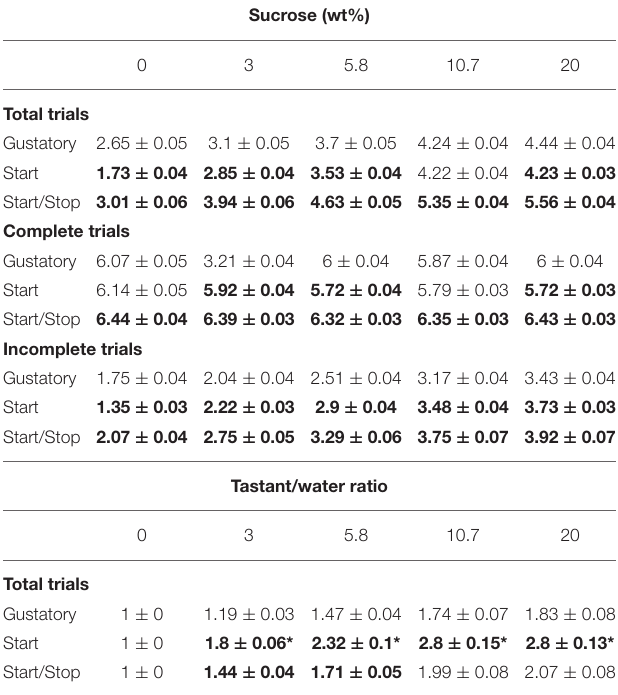
Values are (mean ± sem). Data in bold means p < 0.05, in comparison with Gustatory task. All lick rates (licks/s) were statistically different relative to water (0%) at an alpha level of 0.05. In the Tastant/Water ratio data, * means p < 0.05, in comparison with the Start/Stop task.